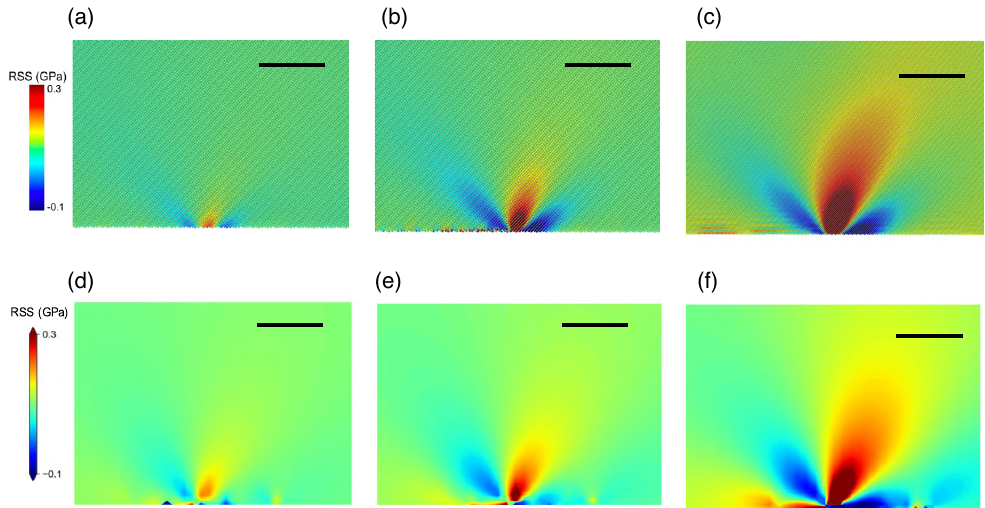
FIG. 4. Comparison of RSS in bulk material due to step height growth (4b, 8b and 18b from left to right) as obtained from molecular dynamics (a – c) and linear elasticity solution (d – f) under an E-field of 10 GV = m. The black solid line indicates a length of 10 nm.